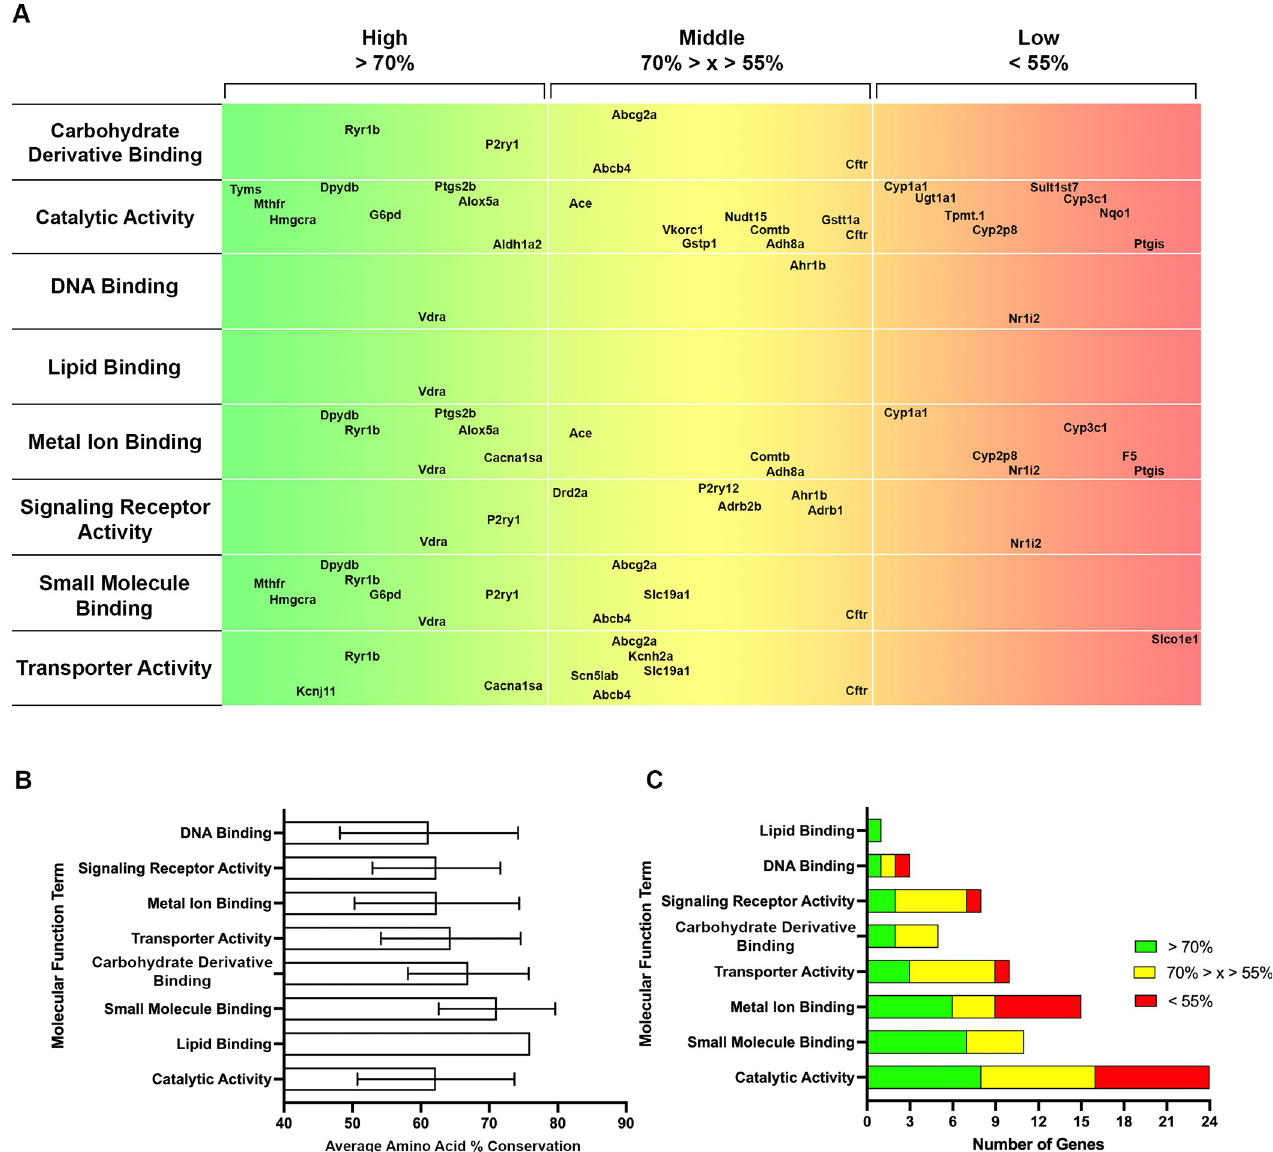
Fig 6. Gene ontology analysis for molecular functions of tiered pharmacogenes. A. A map with the Molecular Function terms listed (left), amino acid sequence conservation in 3 groups: > 70% = High (green to yellow, left to right), 70% > x > 55% = Middle (yellow to orange, left to right), and < 55% = Low (orange to red, left to right). The genes are placed within the respective horizontal location based on their % conservation. B. Average amino acid conservation for each Molecular Function term +/- SD. C. The number of pharmacogenes in each category (High = green, Middle = yellow, Low = red) for each Molecular Function